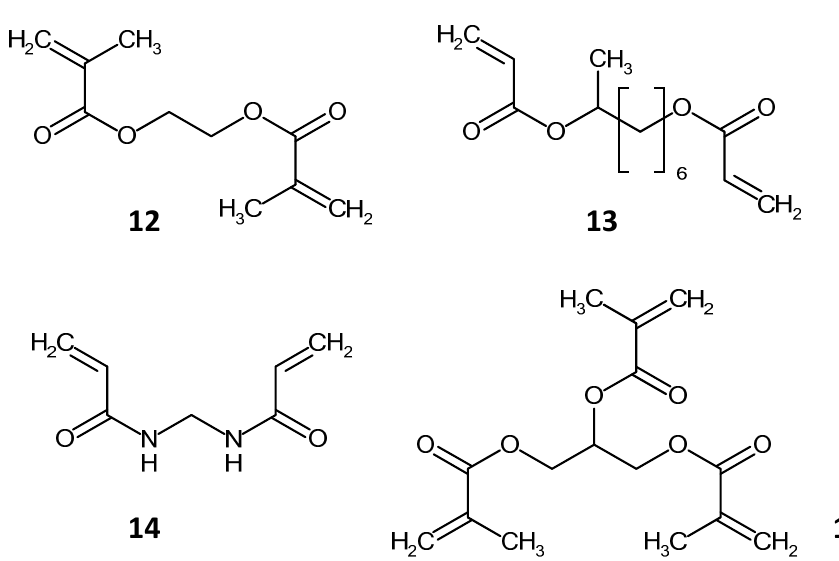
Figure 4. Chemical structures of commonly used cross-linking agents for polymerization reactions. Agents are: ( 12 ) ethylene glycol dimethacrylate; ( 13 ) 2-methyl-1, 8-octanediol dimethacrylate; ( 14 ) methylene bis acrylamide; ( 15 ) tri methylol propane trimethacrylate.